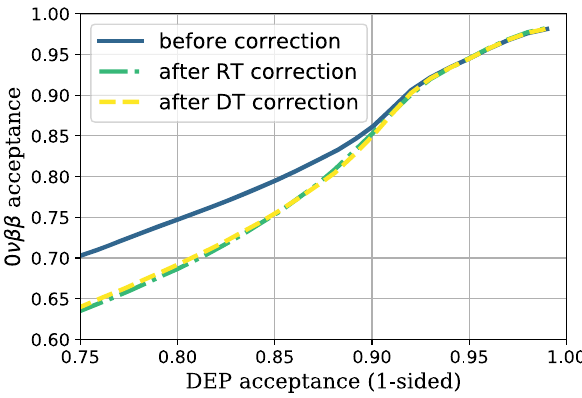
Fig. 7 Acceptance of 0 νββ events as a function of DEP’s, in the case of no-correction on A / E (blue curve), or after rise time (green curve) and drift time (yellow curve)